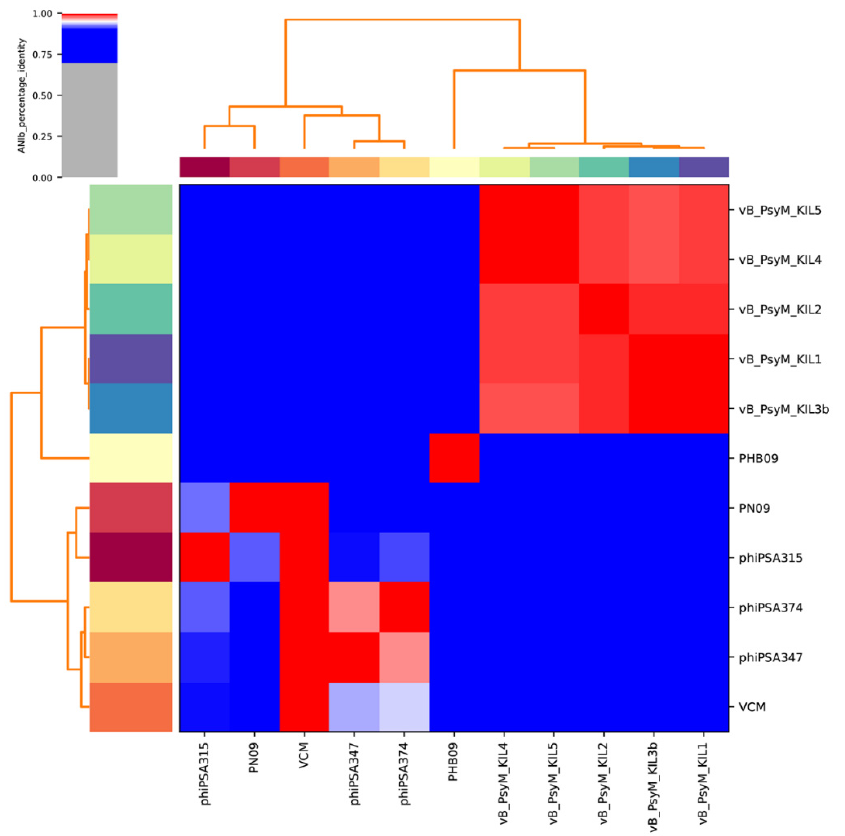
Figure 8. Heatmap of 11 whole genomes . Sequences were from related Otagovirus phages and Flaumdravirus phages in the NCBI database (https://blast.ncbi.nlm.nih.gov/Blast.cgi, accessed on 20 October 2021). The average nucleotide identity (ANI) was valued. Values range from 0 (0%) ANI to 1 (100% ANI): gray represents 0% ANI; clusters of highly similar phages are highlighted in pink and red.